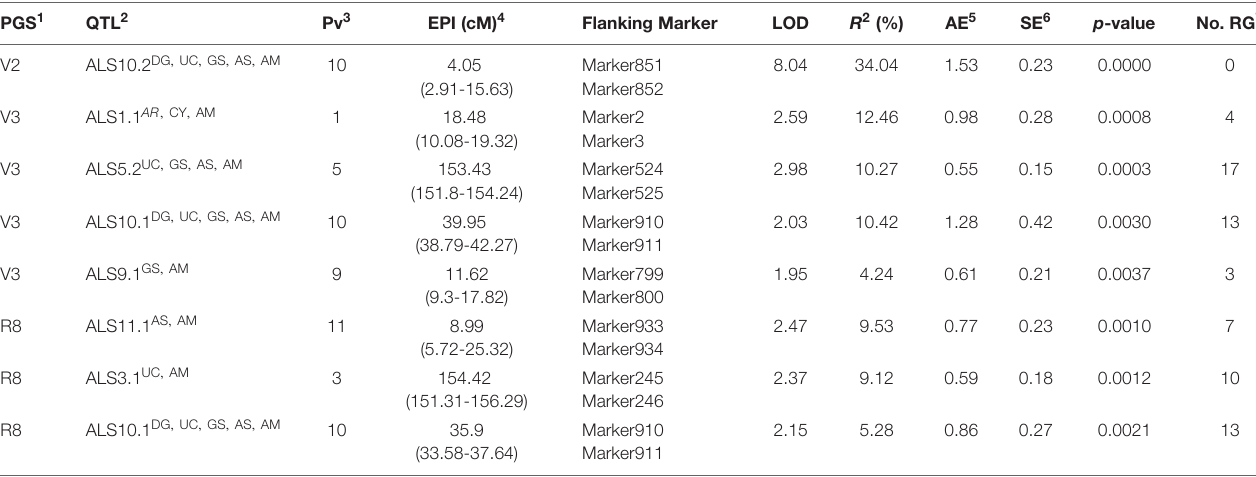
TABLE 4 | Angular leaf spot resistance QTL mapped by multiple intervals (MIM) at different growth plant stages, using the AM population (AND 277 ×